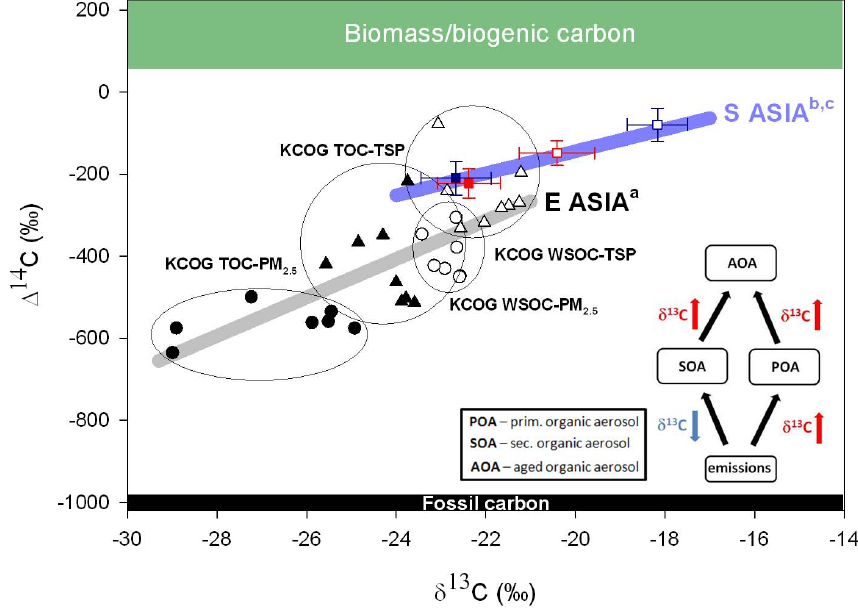
Fig. 4. Two-dimensional presentation of dual-isotope ( δ 13 C vs. 1 14 C) signals of WSOC and TOC in PM 2 . 5 and TSP for (A) GoPoEx campaign in East Asia (dust-influenced samples are excluded) compared to in South Asia (B) Sheesley et al. (2012) and (C) Kirillova et al. (2013) data sets from western-central Indian site of Sinhagad (SINH) and Indian Ocean site on Hanimaadhoo Island, Maldives (MCOH). South Asian data are presented as mean values with standard deviation spread for SINH-TOC (red filled squares), MCOH-TOC (blue filled squares), SINH-WSOC (red open squares) and MCOH-WSOC (blue open squares). Linear fits of TOC and WSOC data are presented as a thick light blue line for South Asia and a grey line for East Asia. The bottom right inset graphically summarizes the general trends of the influence of atmospheric processing on the δ 13 C signature of carbonaceous